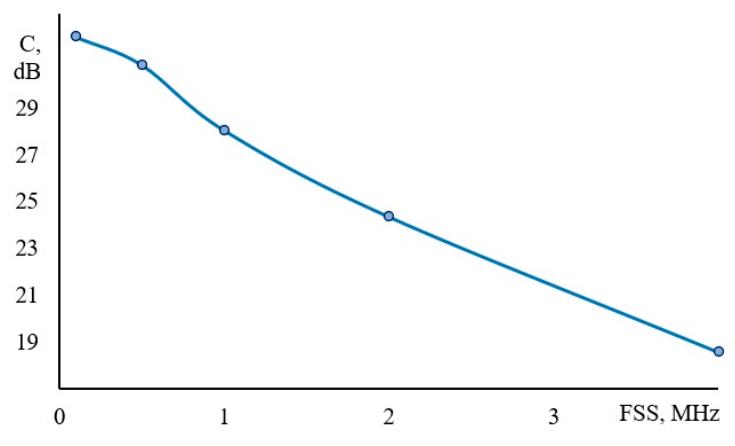
Figure 3. Critical SNR C, dB versus frequency scanning step (FSS), MHz (obtained from simulation).